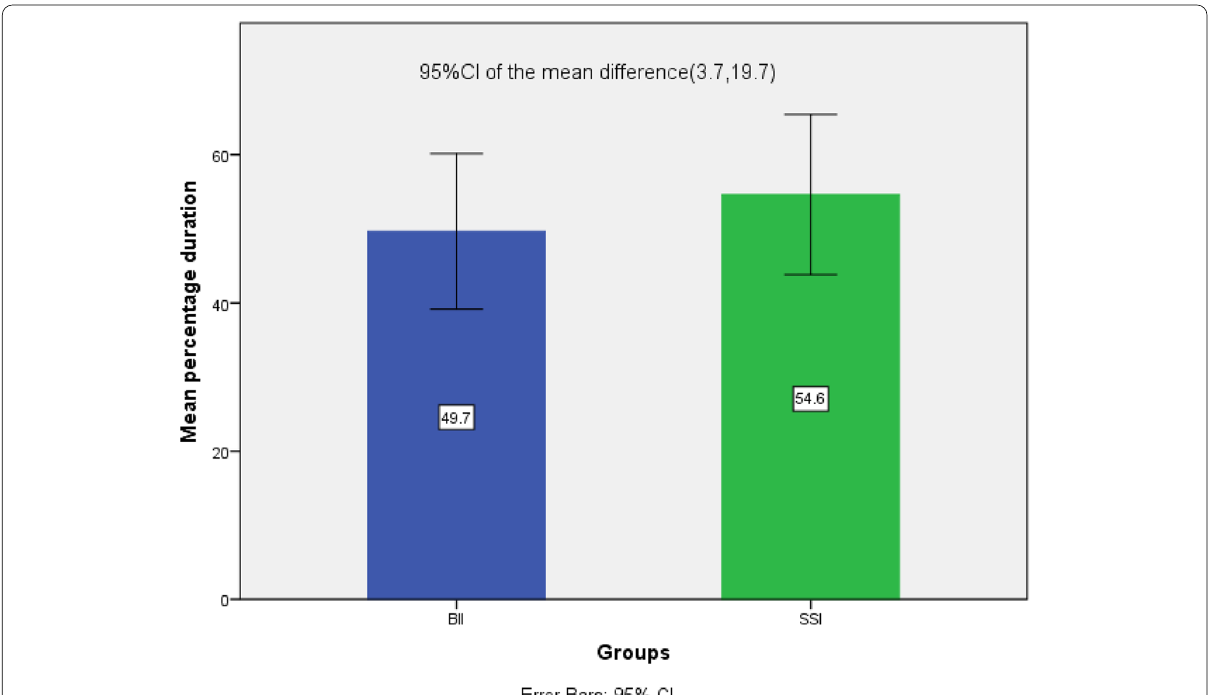
Fig. 5 The mean percentage of operative time with the target CBG range. BII: Bolus‑insulin infusion group, SSI: Sliding scale of insulin group, CBG: Capillary blood glucose, CI: Confidence interval